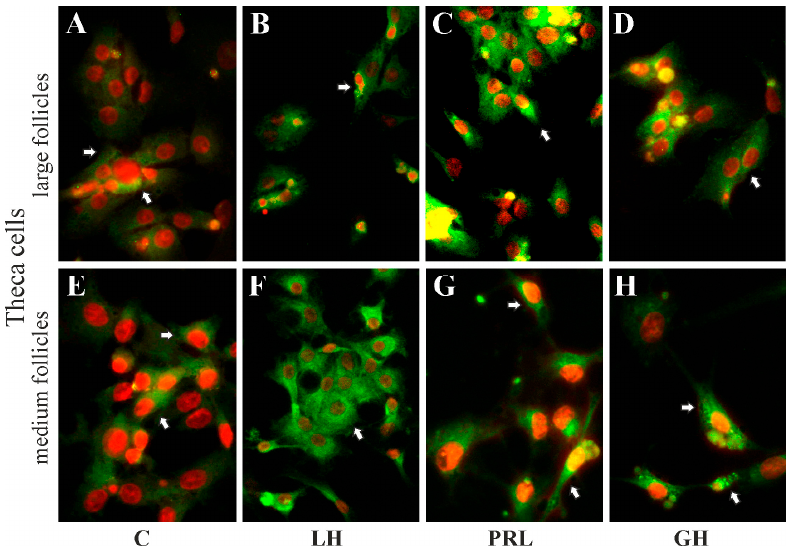
Figure 6. The influence of LH, PRL and GH on subcellular distribution of AQP1 in theca cells of medium and large porcine ovarian follicles. Cells were exposed to LH ( B , F ), PRL ( C , G ) and GH ( D , H ) for 24 h. The cells were fixed and incubated with anti-AQP1 antibody. Alexa-488 was used to visualize AQP1 (in green). Nuclei were stained with propidium iodide (in red). Arrows indicate localization of AQP1 in the cells. The data are representative of five separate experiments, each performed in duplicates. C: control ( A , E ); magnification of 600×.